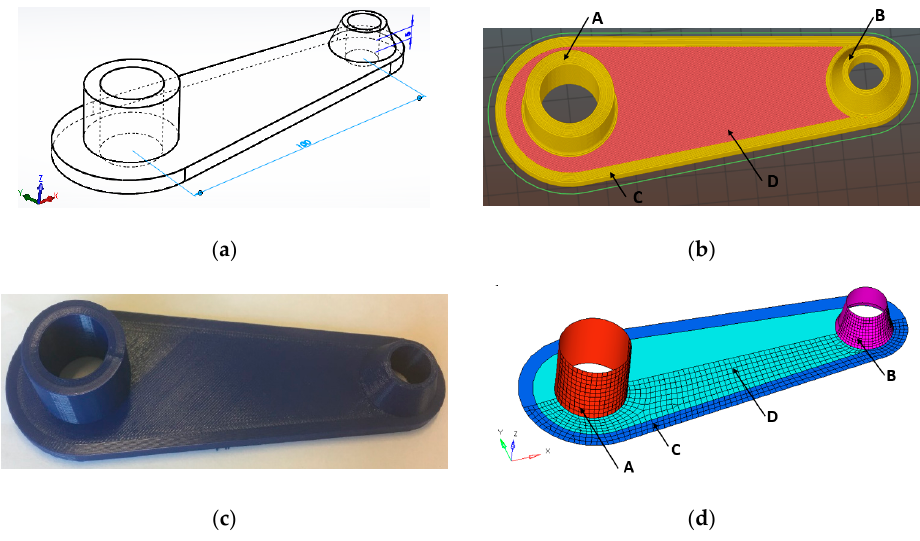
Figure 10. FDM fabricated component and its FE model ( a ) CAD model ( b ) FDM Slicer model for printing; ( c ) FDM fabricated part ( d ) laminated composite 2D finite element model for FEA.